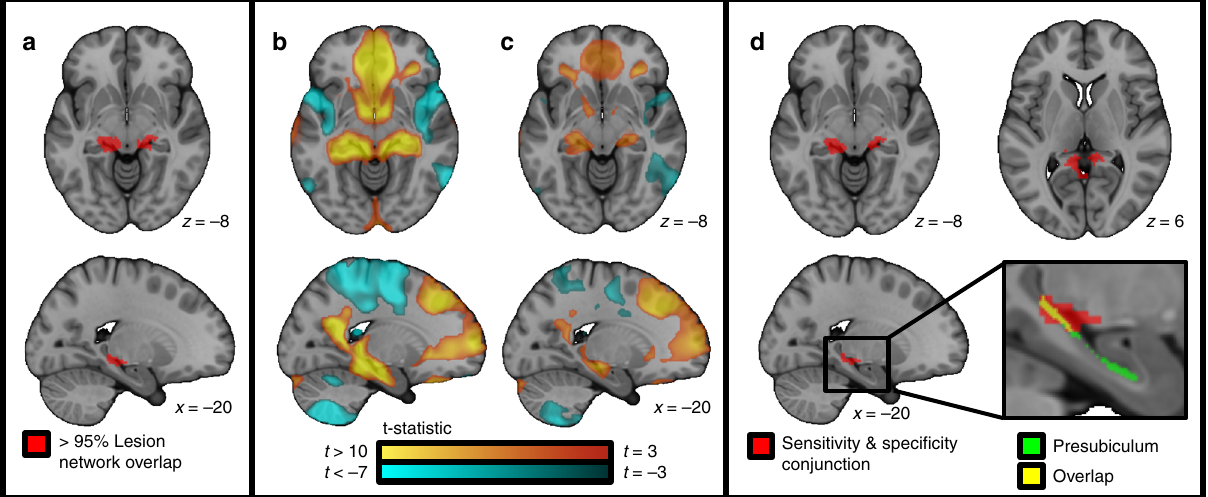
Fig. 3 Sensitivity and speci fi city of lesion network mapping of amnesia. Using our full cohort of lesions causing amnesia ( n = 53), >95% of lesion locations were functionally connected to the junction of the hippocampus and retrosplenial cortex ( a ). This connectivity was speci fi c to lesions causing amnesia compared to a large cohort of control lesions causing non-speci fi c symptoms ( b ) or lesions causing speci fi c symptoms other than amnesia ( c ). (Speci fi city analyses compared unthresholded lesion network maps between amnesia and non-amnesia groups using a voxelwise two-sample t -test corrected for multiple comparisons with a conservative voxel-based Family Wise Error rate p < 0.05.) The conjunction of our sensitivity and speci fi city analyses identi fi es a focal region at the subiculum-retrosplenial continuum ( d ) that overlaps the posterior segment of the Damage to circuit predicts memory in independent datasets . verbal memory (Pearson correlation, r = − 0.21, p < 0.04) and spatial memory scores (Pearson correlation, r = − 0.36, p < 10 − 3 ). Overlap between lesion location and our memory circuit pre- Following penetrating head trauma, intersection between lesion dicted continuous memory scores in an independent dataset of location and our memory circuit was correlated with remote stroke lesions 25 and in an independent dataset of lesions from memory scores for events that occurred close to the time of brain penetrating head trauma 26 (Fig. 4b, c). Immediately after stroke, intersection with our memory circuit was correlated with both injury (Pearson correlation, r = − 0.34, p < 10 − 5 ). All correlations